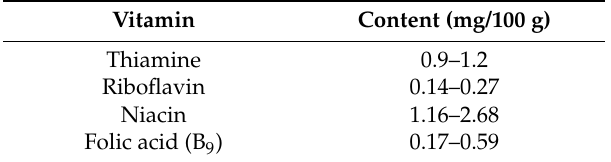
Table 8. Vitamins content of raw common bean. Celaya, Gto. Mexico.